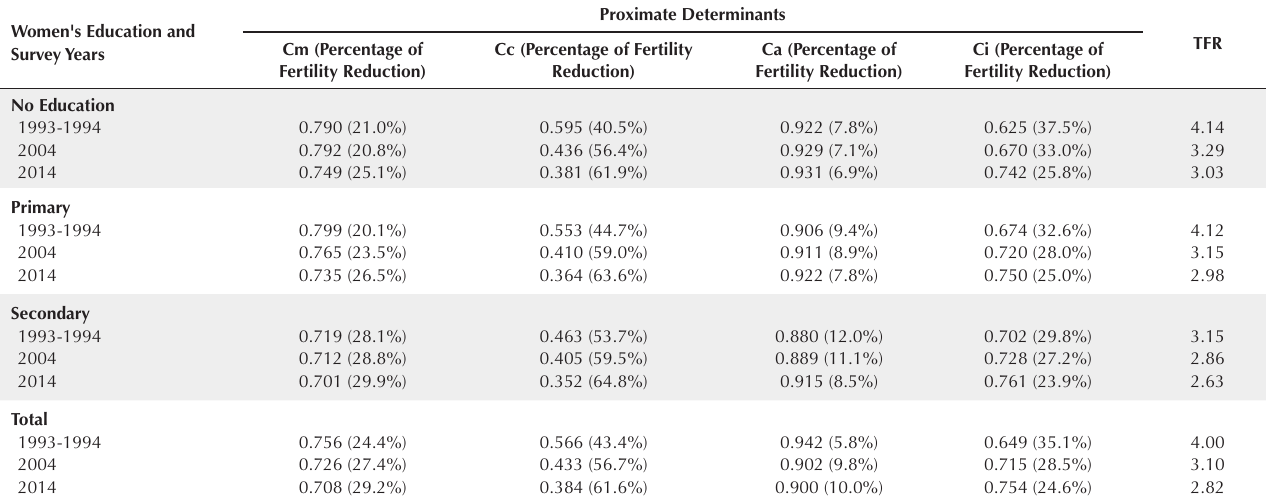
Table 3 . Variations in Proximate Determinants on Fertility Changes according to Women’s Education in Bangladesh: 1993-1994 to 2014 BDHS